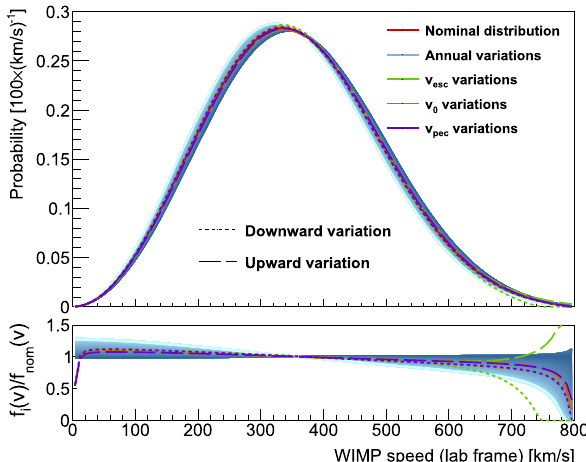
Fig. 7 TheStandardHaloModelWIMPspeeddistributionundervary- ing parameter values. Variations throughout a year are shown in the blue gradient, with darker shades representing times closer to June. The red curve shows the speed distribution for the set of recommended parameters averaged over the full year, approximately equivalent to the distribution on March 9. Green and purple curves show the speed distri- butions with the galactic escape speed and the Sun’s peculiar velocity ( v pec = v (cid:2) )attheirminimumandmaximumvaluessuggestedbygalac- tic survey analyses. The lower plot shows the ratio of each variation divided by the nominal